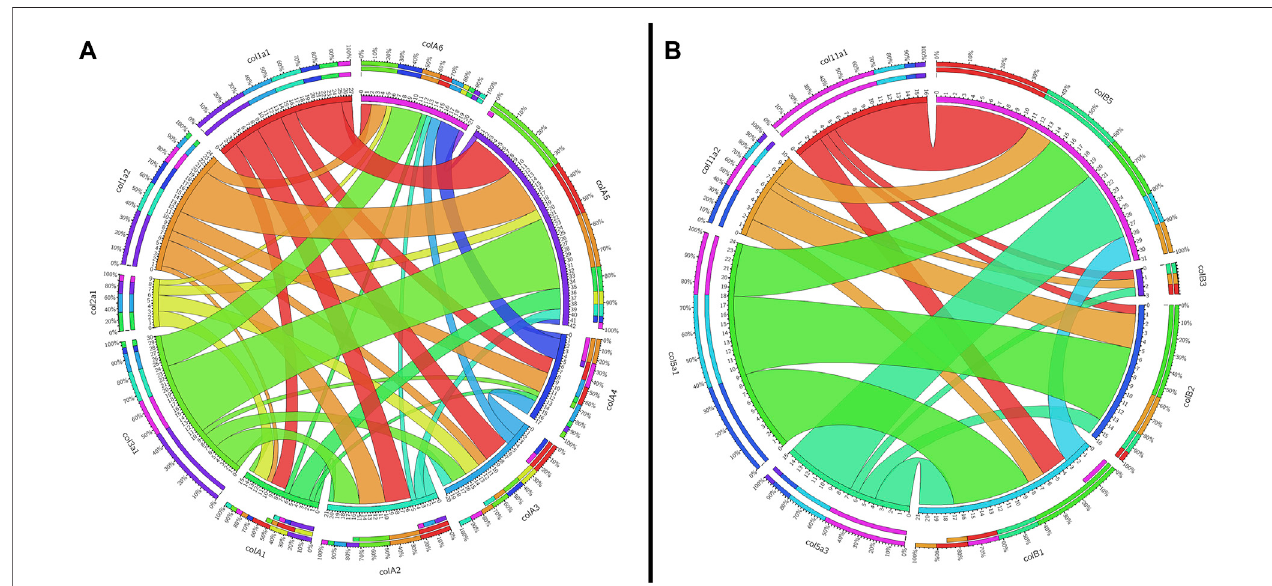
FIGURE 2 | Circos plots showing the synteny between gnathostome and lamprey Clade (A) and Clade (B) fi brillar collagens. Inner circles are colored according to that gene, and they indicate the total number of linked genes and how many are syntenic with other fi brillar collagens. Outer circles show percentages of linked genes. Syntenybetweengnathostomegenesisnotshown. (A) Shared linkagebetweengnathostomeandlamprey Clade Agenes.All genesofinterest inthisplotaswell asthe grid used togenerate itcan be found in Supplementary Table S4 . Because col3a1 and col5a2 are linked together, the latter is not shown on the plot. (B) Shared linkage between gnathostome and lamprey genes. All genes of interest in this plot as well as the grid used to generate it can be found in Supplementary Table S5 .